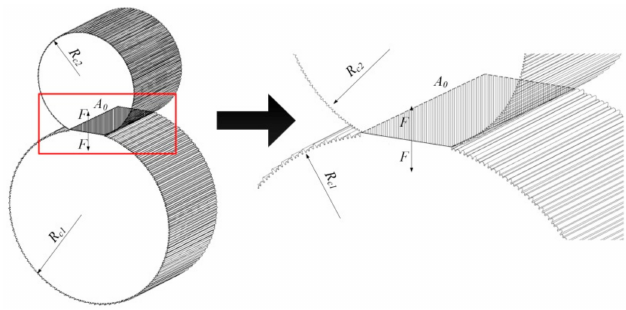
Figure 1. The contact between two cylindrical rough